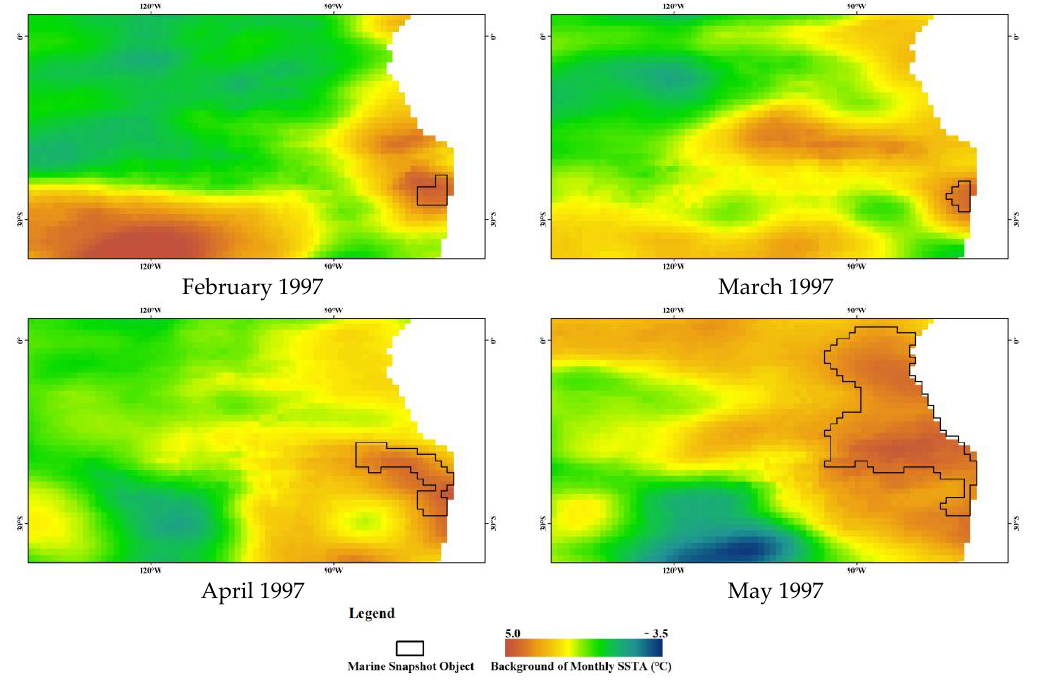
Figure 8. Sequence object 1 originates and expands in the Eastern Pacific Ocean from February to May 1997. The background is the monthly SSTA.